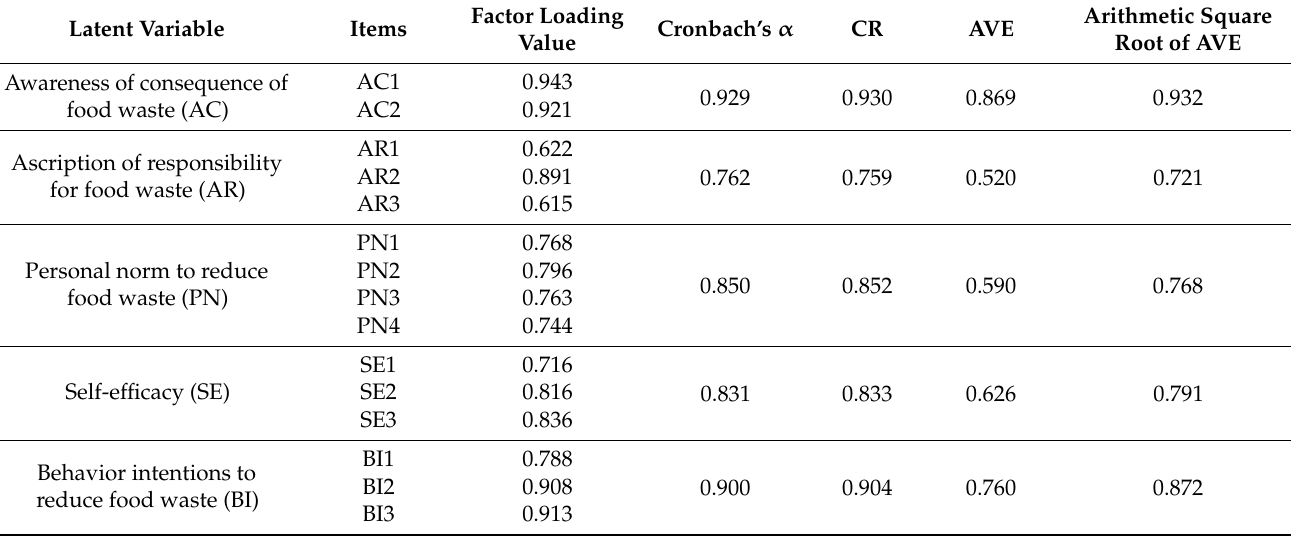
Table 3. Reliability analysis and convergence efficiency analysis